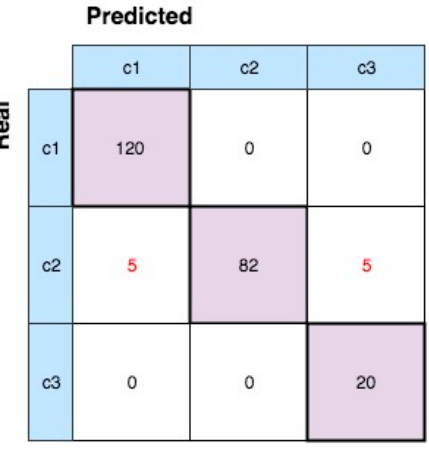
Figure 10. Confusion matrix.